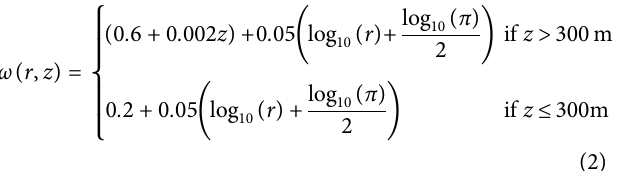
Frontiers in Earth Science |